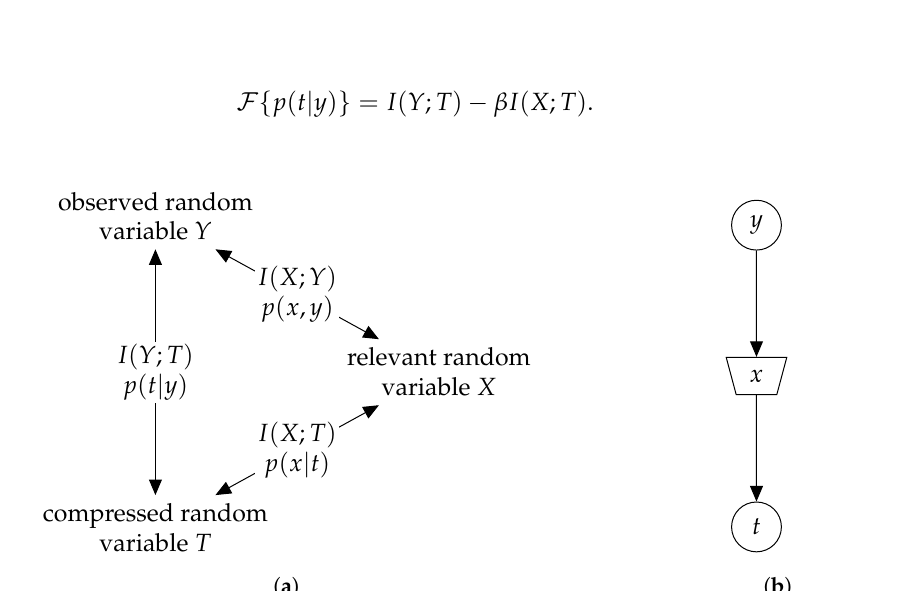
Figure 3. ( a ) Information bottleneck setup, where I ( X ; T ) is the relevant information, I ( X ; Y ) is the original mutual information, and I ( Y ; T ) is the compression information. The goal is to determine the mapping p ( t | y ) which maximizes I ( X ; T ) and minimizes I ( Y ; T ) . ( b ) Information bottleneck graph for the elementary setup of ( a ). The realizations of Y are mapped onto those of T such that their relevance to X is preserved, i.e., I ( X ; T ) ≈ I ( X ; Y ) , and |T | < |Y|